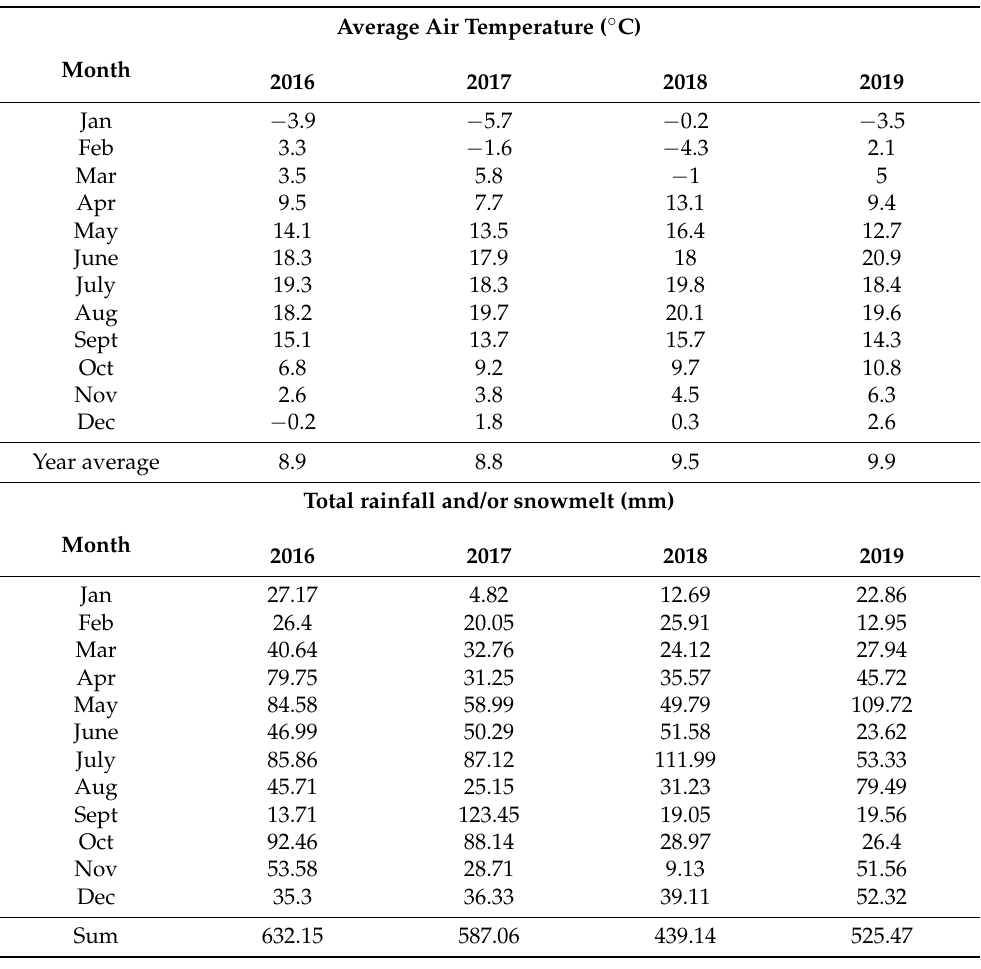
Table 1. Values of basic meteorological conditions (temperature and precipitation) for the months and years during the study period 2016–2019. Data are reported by weather station no. 125,950 (Zamo´s´c